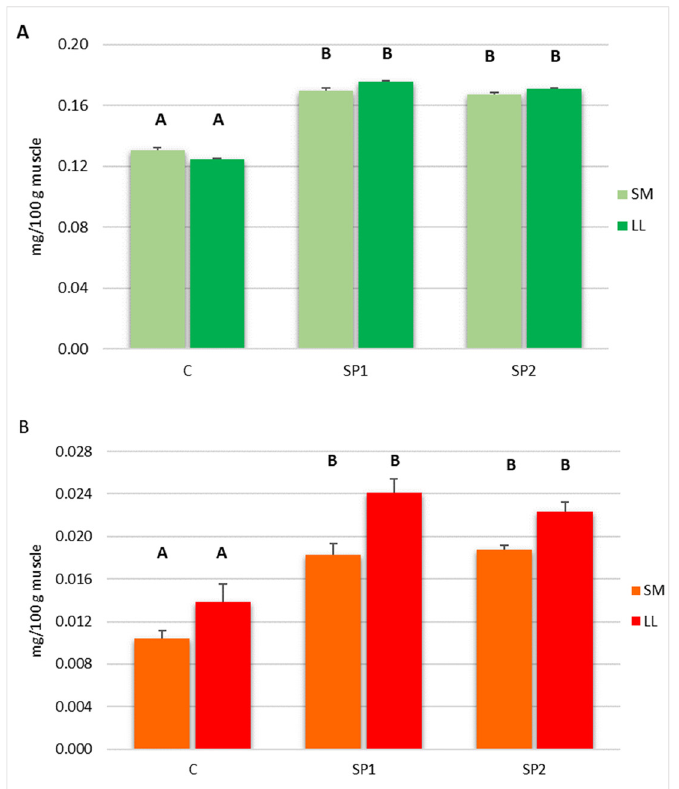
Figure 1. α -tocopherol ( A ) and retinol ( B ) content of Longissimus lumborum (LL) and Semimembranosus muscle (SM) of rabbits fed control diet (C) and diet supplemented with 3 g/kg (SP1) and 6 g/kg (SP2) of brown seaweed and plant polyphenols. Data are reported as means ± standard error of the means (SEM); n = 12. A,B values with different superscript letters are different at p < 0.001.